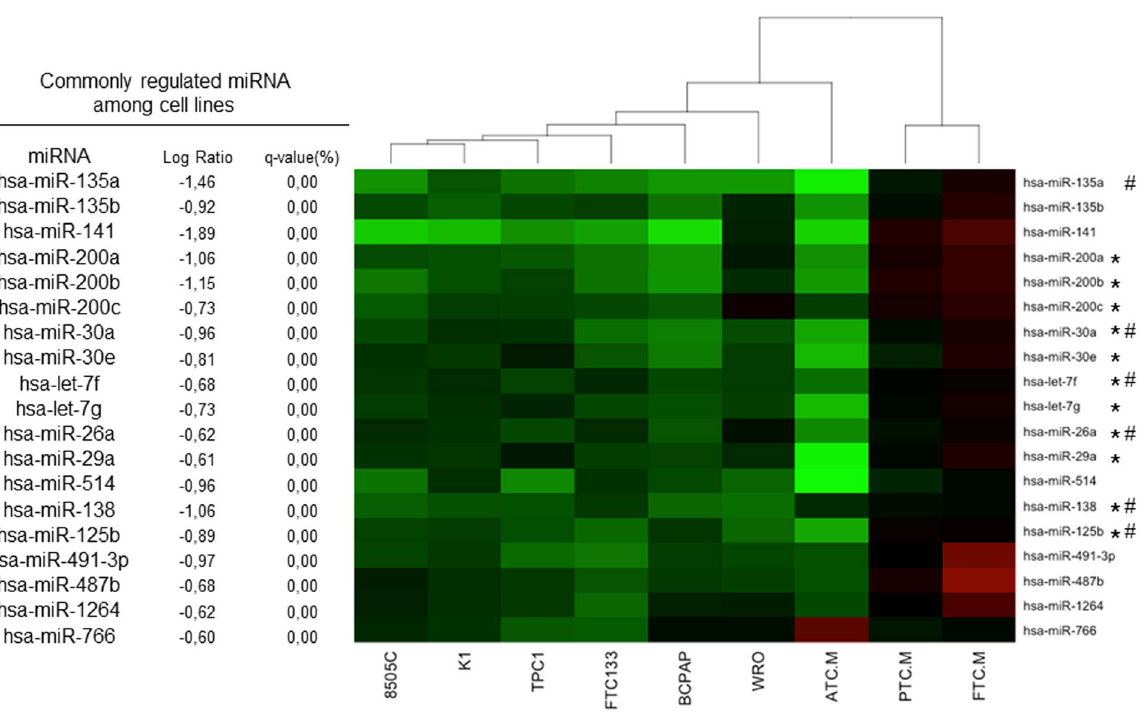
Figure 4. Heatmap based on the results of SAM one class analysis of the microarray data from 6 thyroid cancer cell lines and compared to tumor tissues. 18 of the 19 modulated miRNA in cell lines are modulated in the same way in ATC, but are not modulated or in an opposite way in differentiated tumors (PTC and FTC). The heatmap was generated using R 2.14.1. with the library ‘‘gplots’’. ATC.M (n=11), PTC.M (n=8) and FTC.M (n=8) refer to the mean of the miRNA data from the different tumors analyzed. * miRNA described as regulated in ATC by Braun et al [23]. # miRNA described as regulated in ATC by Visone et al. [24].